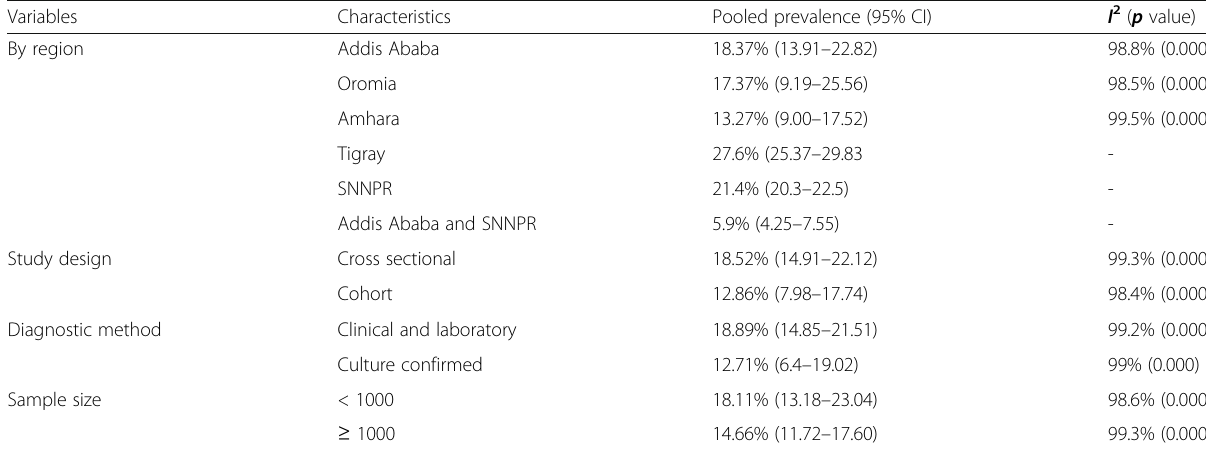
Table 2 The prevalence of HCAI, 95% CI and heterogeneity estimate with a p-value for the subgroup analysis by study region, design, diagnostic method and sample size